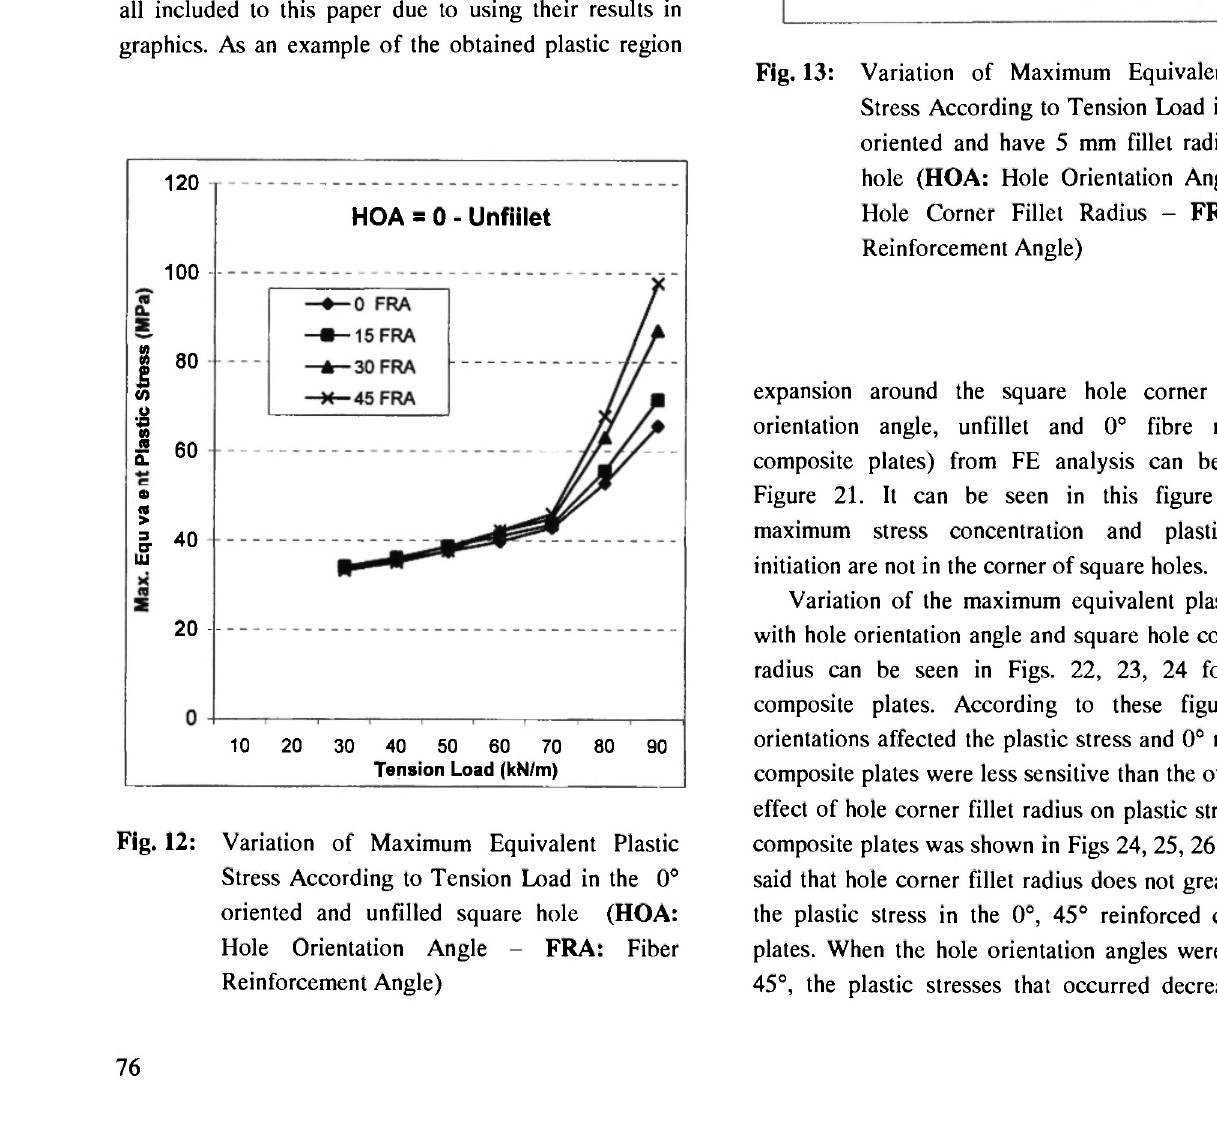
Fig. 13: Variation of Maximum Equivalent Plastic Stress According to Tension Load in the 0° oriented and have 5 mm fillet radius square hole (HOA: Hole Orientation Angle - r : Hole Corner Fillet Radius - FRA: Fiber Reinforcement Angle)